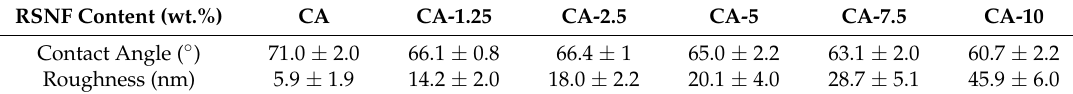
Table 1. Contact angle and roughness measurements of CA and CA/RSNF films.